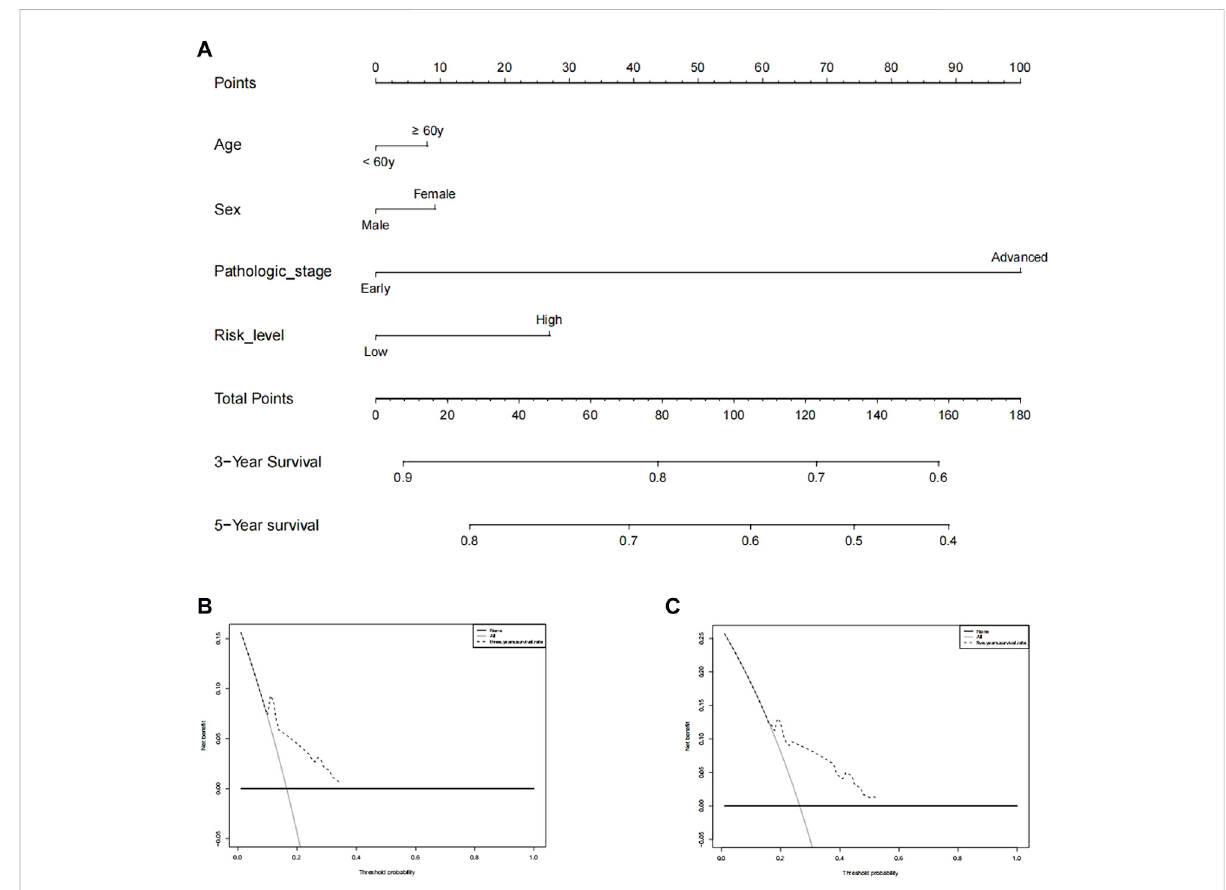
FIGURE 5 Prediction of 3- and 5-year survival probabilities for nomogram LUAD patients. (A) An upward line is drawn from these values to a “ score ” line based on age ( ≥ 60or < 60 years), sex, pathological stage (early stagesincludestages 1 and 2, advanced stages include stages3 and 4), and risk levels. Points are calculated by drawing an upward vertical line on the “ points ” column. Adding these “ points ” gives the “ total point ” and a vertical line is drawn down from the “ totalpoint ” line to count the3-year and5-year livingprobabilities. (B,C) Decisioncurveanalysis ofmulti-Cox modelsfor 3 and 5 years,